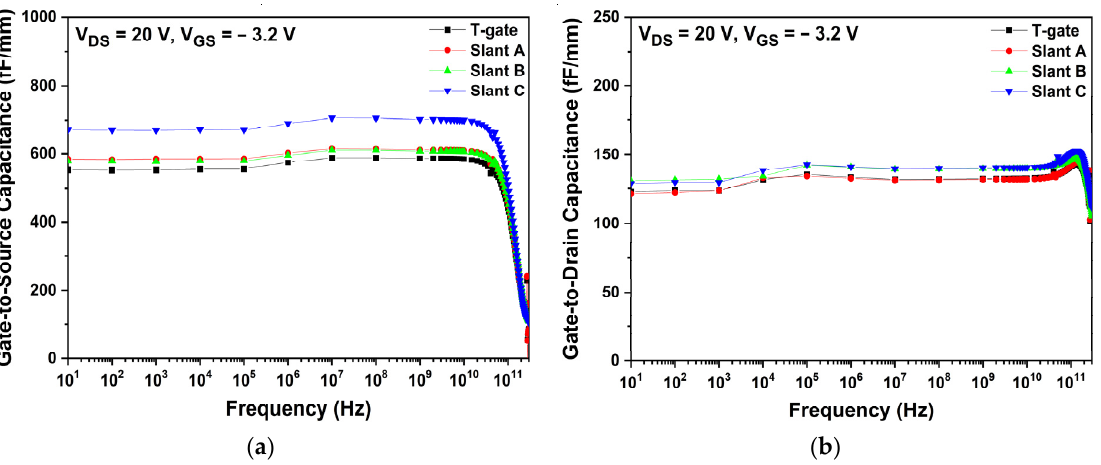
Figure 9. Capacitance characteristics as a function of frequency for different gate structures: ( a ) gate-to-source capacitance; ( b ) gate-to-drain capacitance.